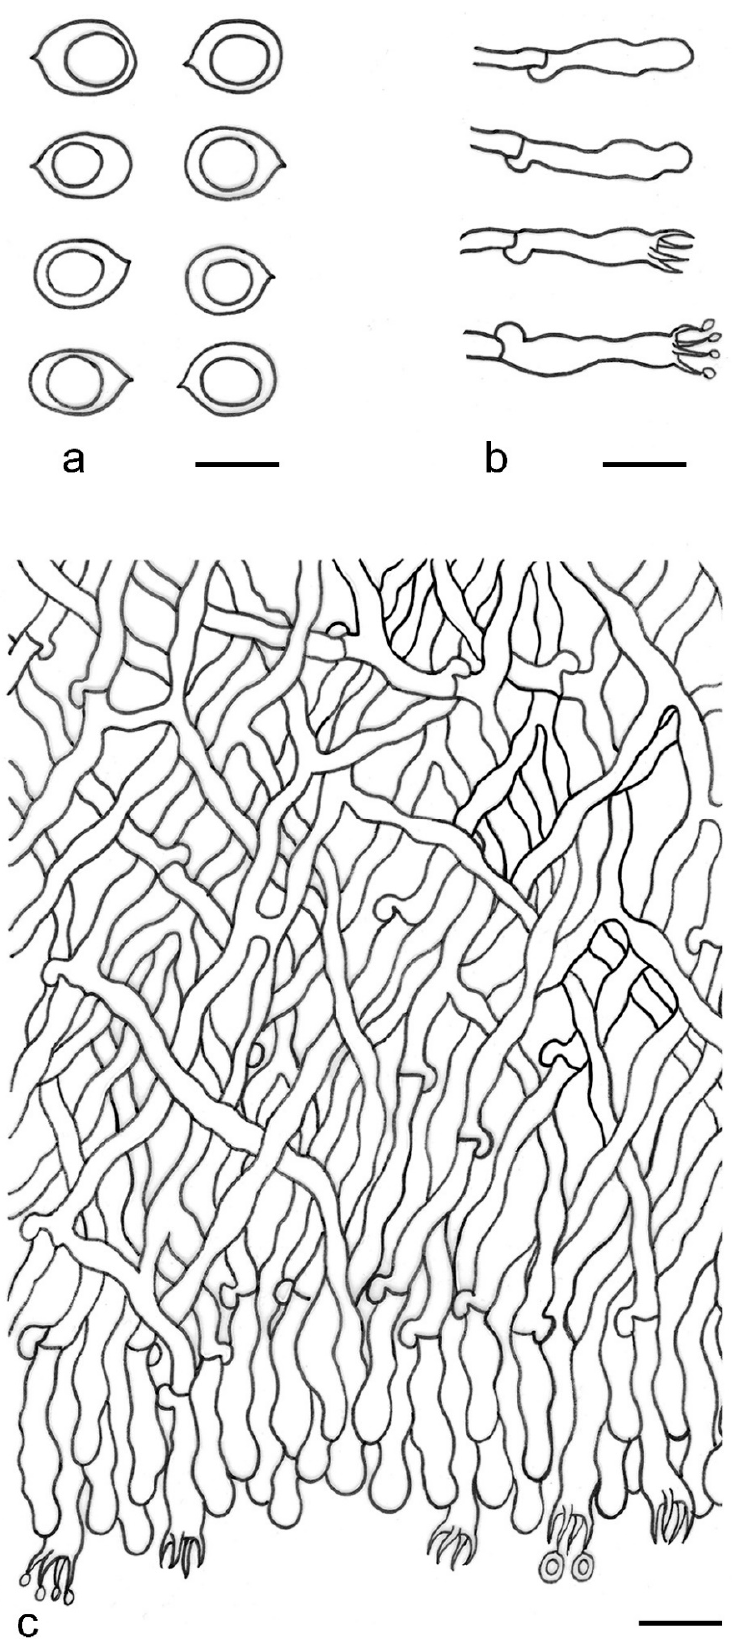
Figure 21. Microscopic structures of Xylodon acystidiatus (drawn from the holotype). ( a ) Basidiospores; ( b ) basidia and basidioles; ( c ) a section of the basidiocarp.—Scale bars: a = 5 μ m; b , c = 10 μ m.